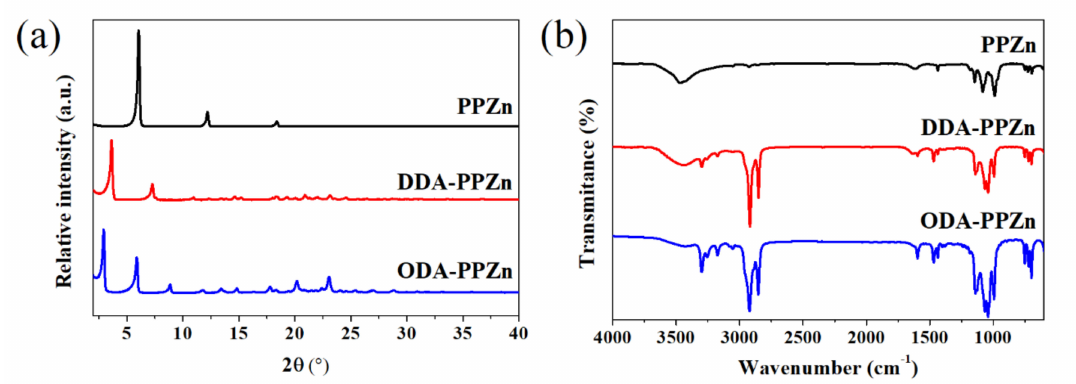
Figure 2. ( a ) X-ray di ff raction patterns for PPZn, dodecylamine (DDA)-PPZn and octadecylamine (ODA)-PPZn. ( b ) FTIR spectra of PPZn, DDA-PPZn, and